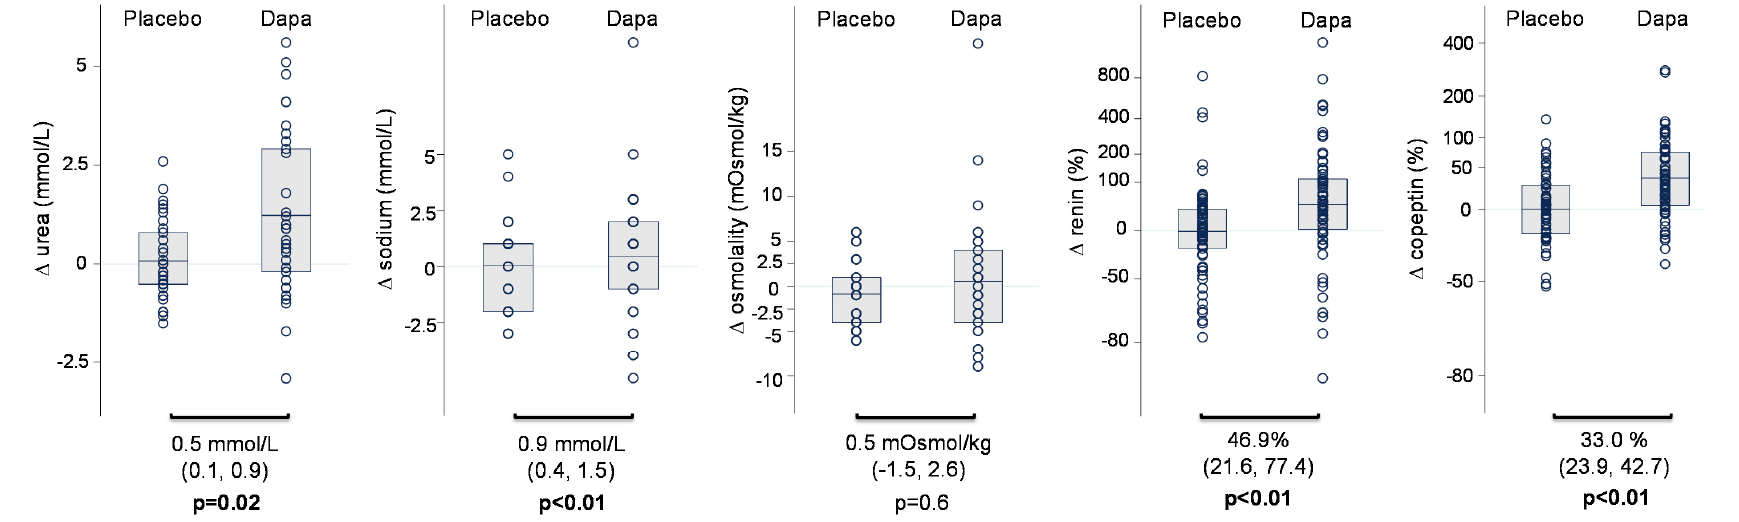
Figure 2. Changes in plasma volume markers during dapagliflozin treatment versus placebo treatment in the merged database.